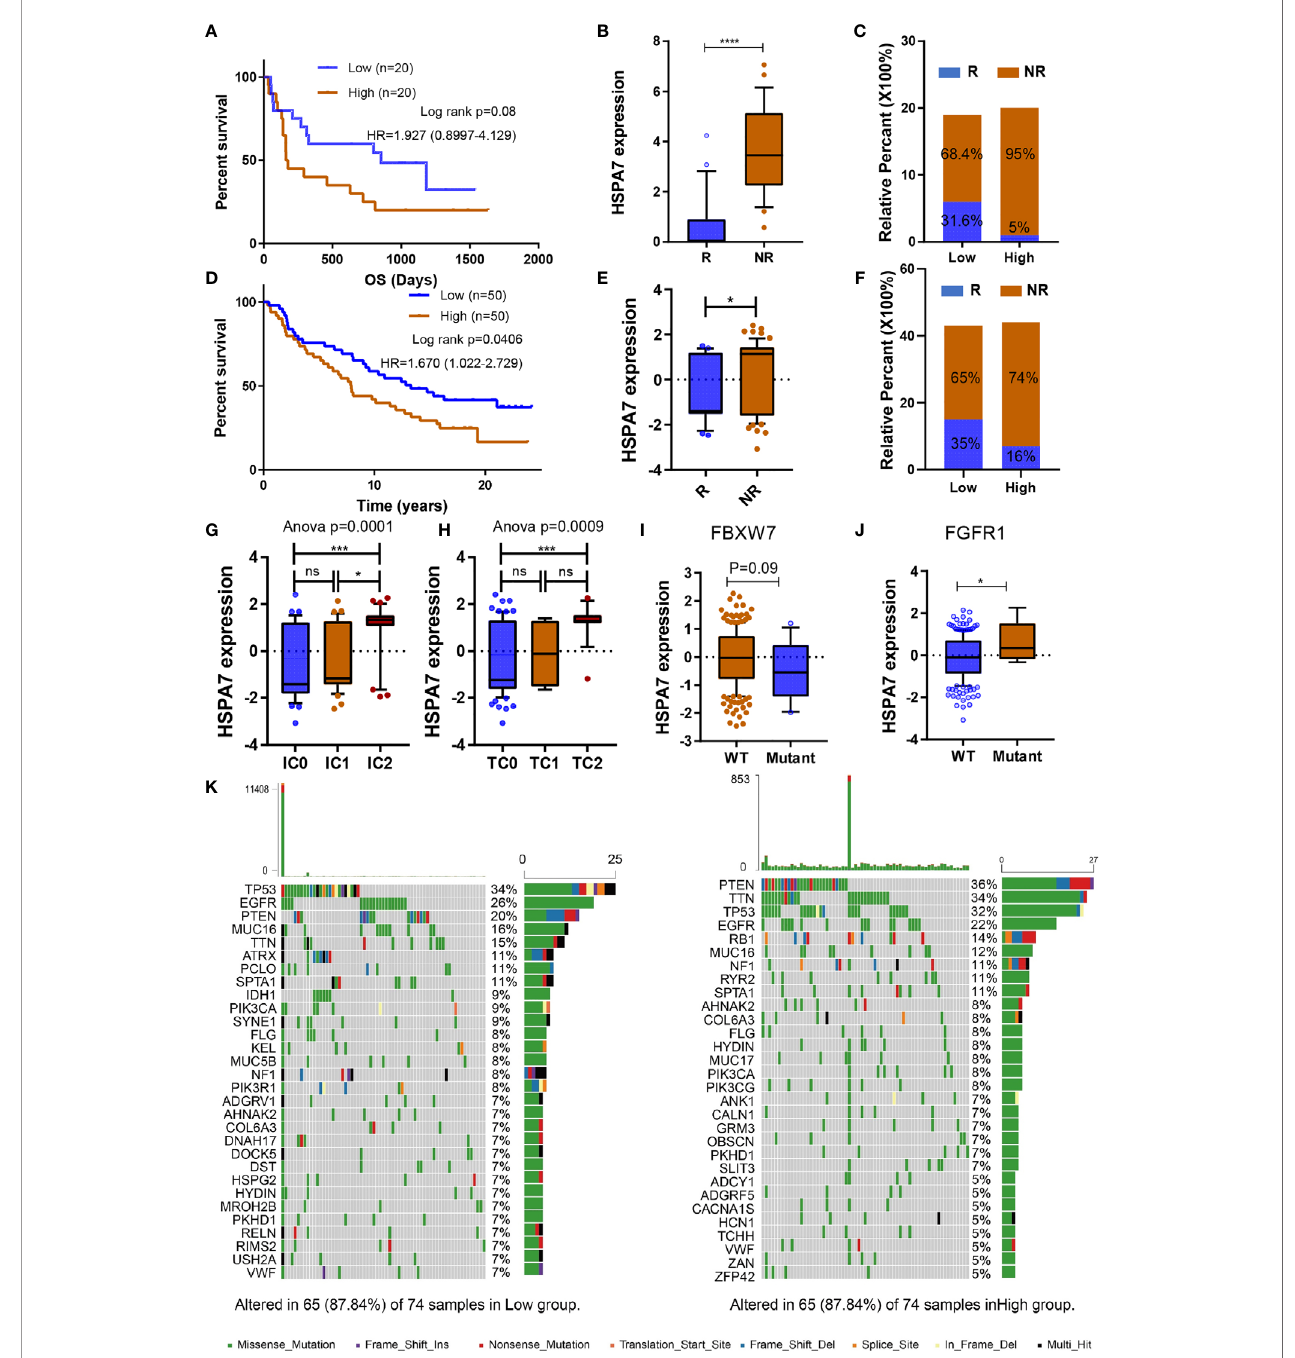
FIGURE 6 | HSPA7 holds promise for predicting the therapeutic response to ICB. (A) The Kaplan – Meier survival curves showed that HSPA7 was a prognostic risk factor in the melanoma cohort that received anti-CTLA4 therapy. (B) Expression of HSPA7 in distinct anti-CTLA4 clinical response groups, R, response; NR, no response. (C) The proportion of patients who responded to CTLA4 blockade immunotherapy in the low or high HSPA7 expression groups. (D) The Kaplan – Meier survival curves showed that HSPA7 is a prognostic risk factor in the anti-PD-L1 cohort (IMvigor210). (E) Expression of HSPA7 in distinct anti-PD-L1 clinical response groups, R, response; NR, no response. (F) The proportion of patients who responded to PD-L1 blockade immunotherapy in the low or high HSPA7 expression groups. PD-L1 expression in both ICs (G) and TCs (H) was associated with HSPA7 expression, with the highest PD-L1 expression level in cells showing the highest HSPA7 expression. (ANOVA, p = 0.0001, p = 0.0009, respectively). HSAP7 expression between (I) FBXW7 wild-type (WT) and mutant status and (J) FGFR1 wild- type (WT) and mutant status. (K) The waterfall plot of tumor somatic mutations established by those with high HSPA7 expression (right) and low HSPA7 expression (left). The statistical signi fi cance is shown as: ns, P > 0.05; *P < 0.05; ***P < 0.001; ****P <